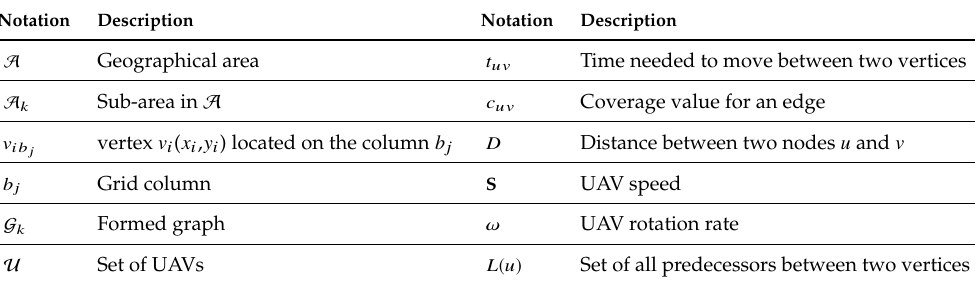
Table 2. Table of